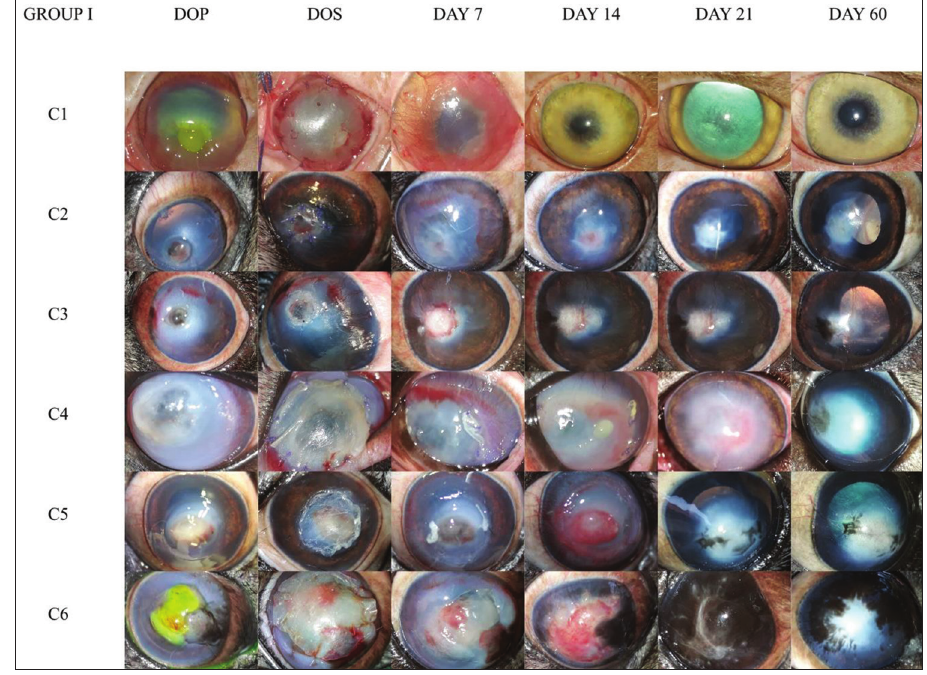
Figure-1: Gross photographs of corneas in Group I on the days of presentation, surgery, and post-operative days 7, 14, 21, and 60. C1: Extensive lesion of 13 mm diameter involving the whole cornea with visible prolapse of Descemet’s membrane that did not retain fluorescein dye but was disrupted at the center, exposing endothelium where the FDT was positive. The edges were healthy with progression of superficial blood vessels from the limbus. Graft uptake with intense neovascularization on post-operative day 7 resulted in absolute corneal clarity by day 14. C2: Axially located 6 mm diameter full-thickness defect with iris prolapse and localized edema. The cornea became hazy due to diffuse edema and vascularization by day 7, regained moderate clarity by day 14, and was completely clear by days 21 and 60, except for the central scar. C3: Full-thickness defect of 4 mm diameter with iris prolapse, localized corneal edema, and superficial vascularization. The cornea regained clarity by the end of the observation period, except for mild pigmentation. C4: Severely melting cornea with an 8 mm diameter full-thickness defect which stained fluorescein positive with dense edema and pannus all around the peri-limbal cornea. Corneal opacity due to edema complicated by stromal bullae retained up to day 14 post-grafting, which improved by day 21 and left a central scar remaining on day 60. C5: 6 mm diameter axially located full-thickness defect complicated by iris prolapse, melting edges, and miosis. The cornea became edematous by day 7 post-grafting and profusely vascularized by day 14, leaving considerable fibrosis and mild pigmentation by day 60. C6: Extensive chronic melting ulcer with irregular borders, diffuse corneal edema, and progression of pigmentation from the nasal limbal border, as the sclera was also heavily pigmented toward the medial canthus. Melting persisted on day 7, as well as complete opacity due to the central granulation tissue, profuse vascularity, and pigmentation on day 14. The cornea became extensively pigmented with an irregular scar at the center by day 21, which remained until the end of the observation period with pigmentation interspersed with a central scar. DOP=Day of presentation, DOS=Day of